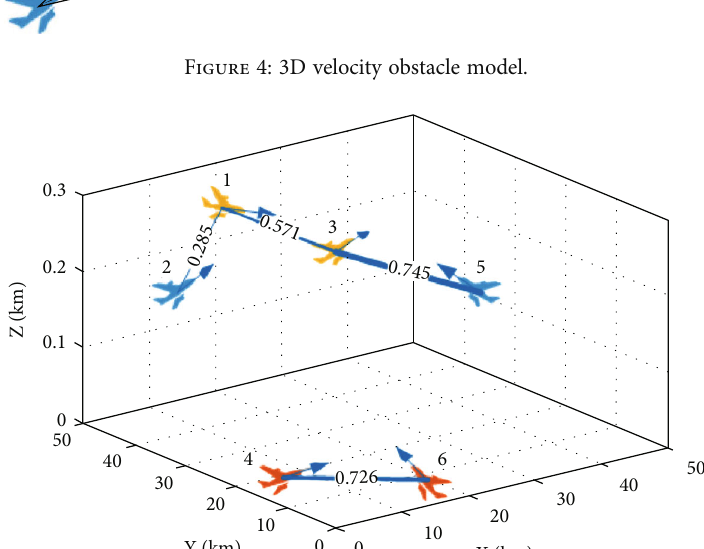
Figure 5: Flight collision network